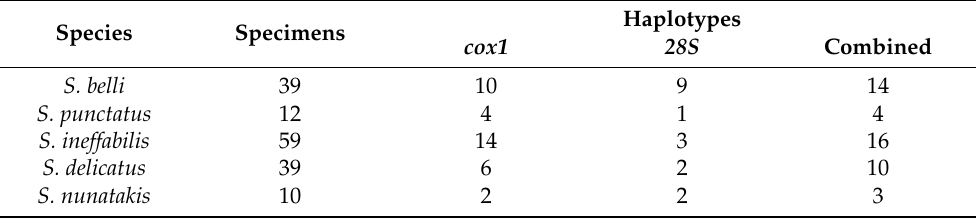
Table 4. Number of specimens analyzed per species and number of haplotypes detected within the species for the mitochondrial and nuclear markers and the combined set of the cox1 and 28S (combined).